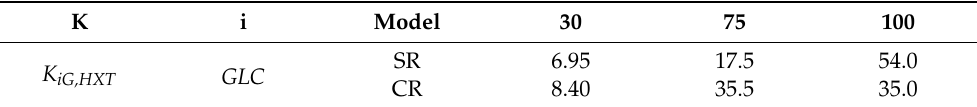
Table A4. Apparent substrate transport saturation constants K GLC (mM), equilibrium constants, and other constants of the SR and CR models as a function of the substance according to the initial concentration of fermentation in g L − 1